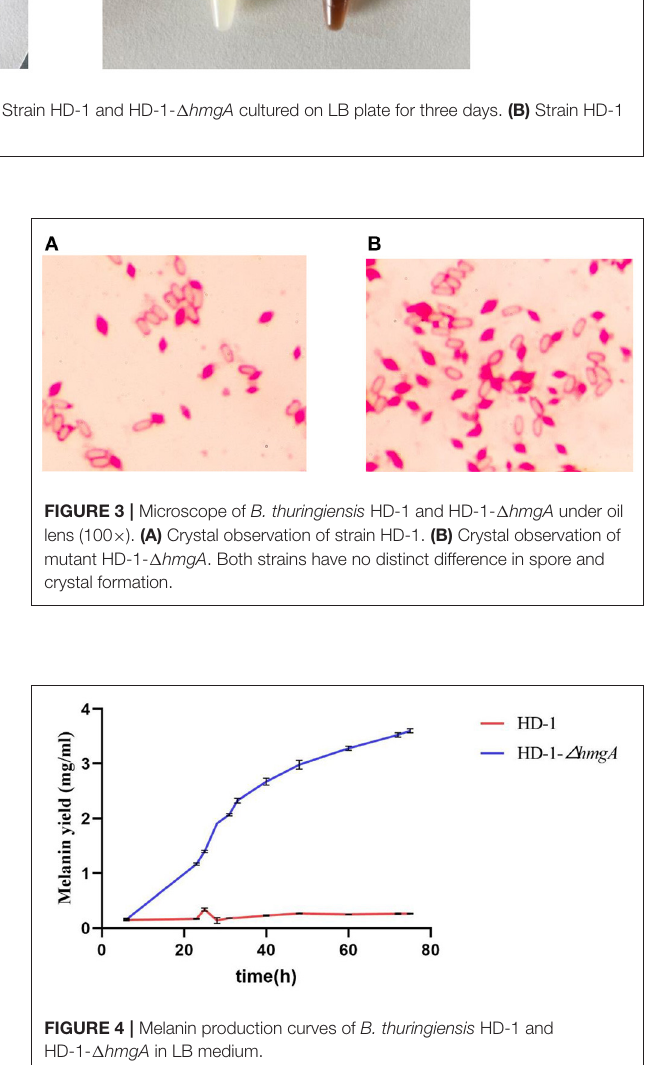
after centrifugation. The melanin yield was calculated based on a standard curve performed on purified melanin. Figure 4 showed that strain HD-1- 1 hmgA began to produce melanin during the logarithmic phase, and the highest yield reached 3.60 mg/mL after culturing for 3 days. On the contrary, we were unable to detect the formation of melanin in strain HD-1